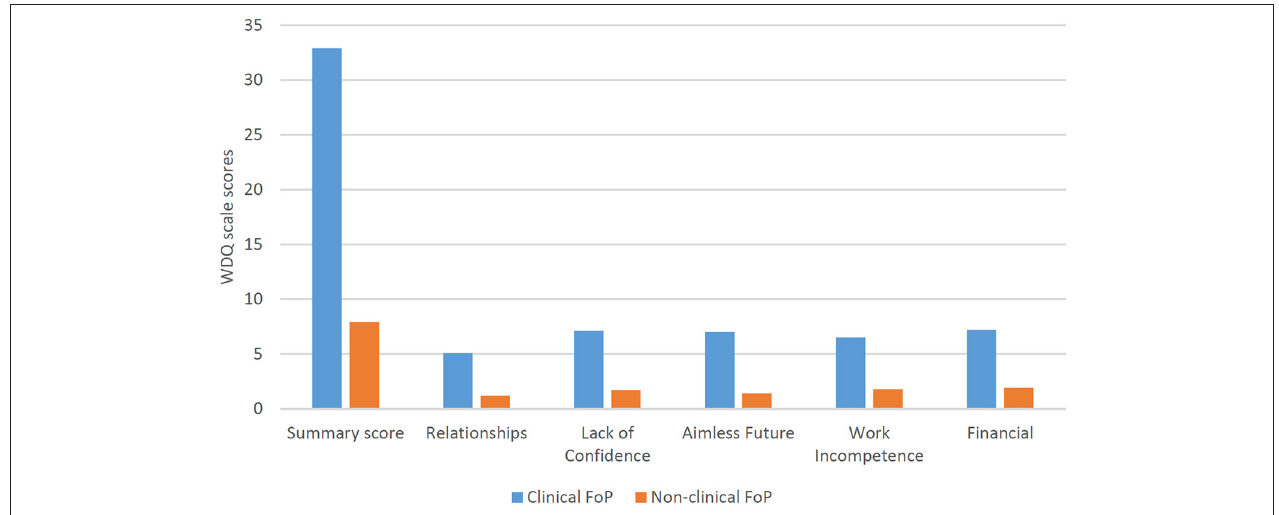
FIGURE 1 | Differences in the scales of the Worry Domains Questionnaire between patients with cancer with clinical versus non-clinical fear of progression (FoP-Q; cut off: 80th percentile).